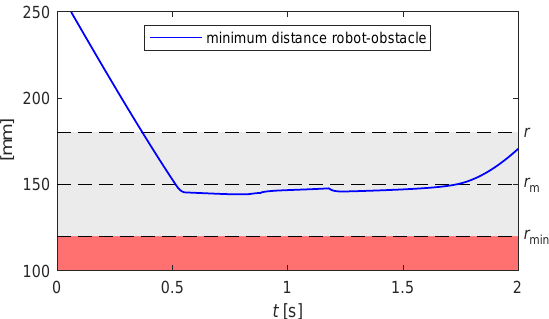
Figure 13. Example 2: minimum distance robot-obstacle for the motion shown in Figure 12.